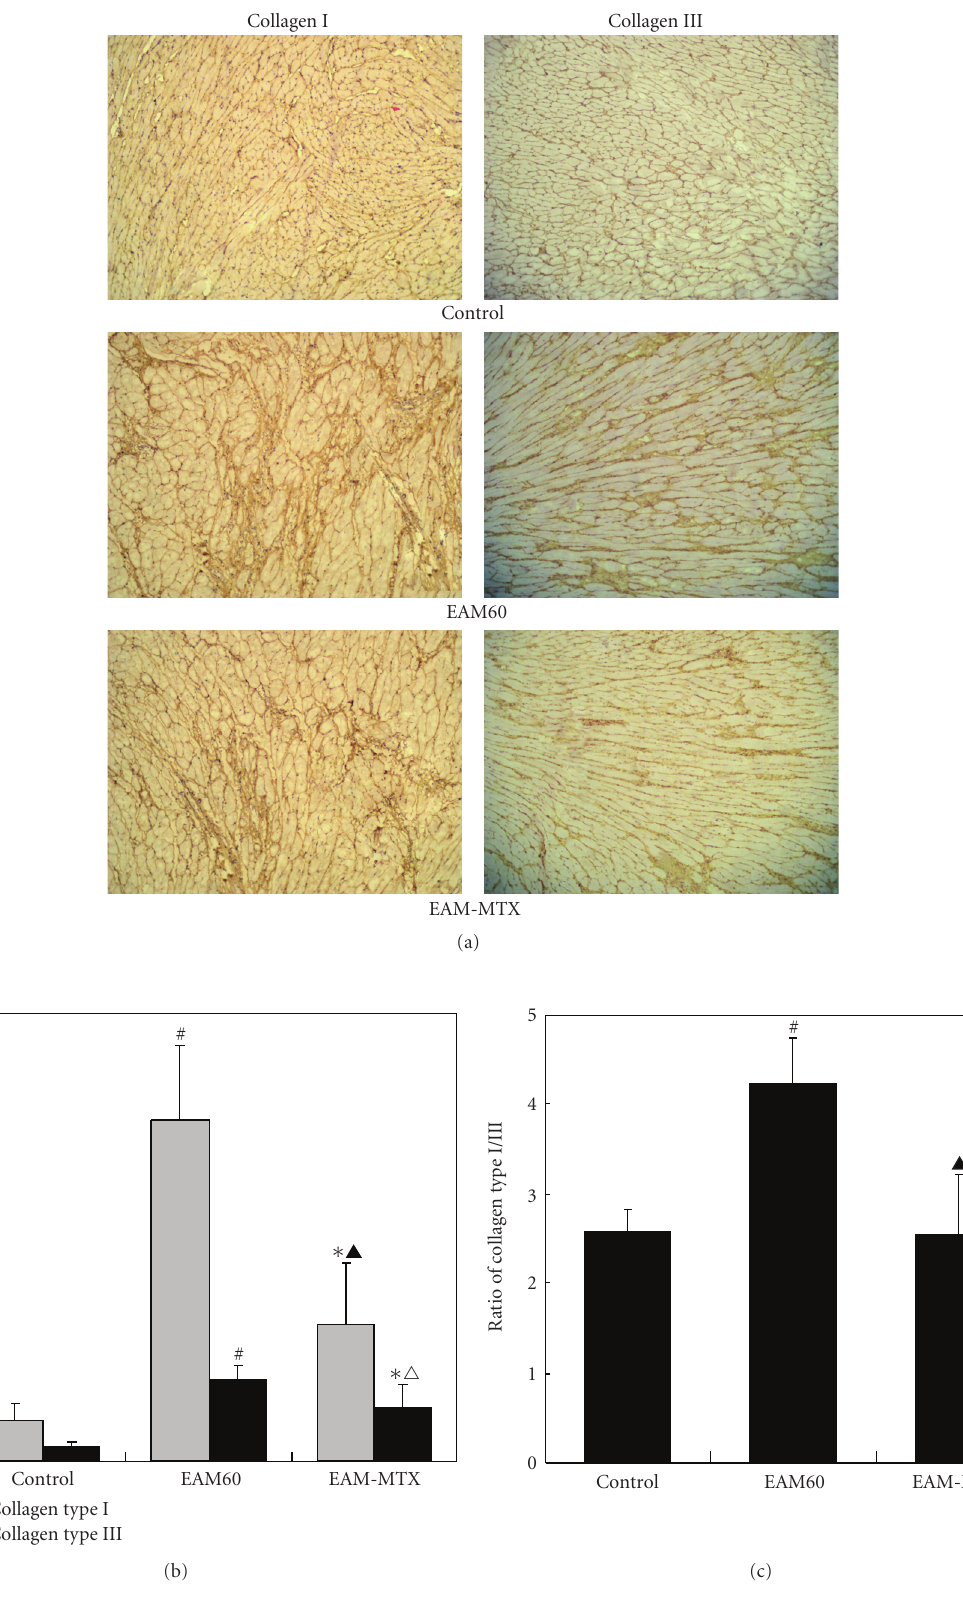
Figure 4: Collagen types I and III staining. Representative photomicrographs of ventricular sections from the three groups of rats are shown ((a); × 200). The areas of collagen types I and III were, measured (b) and the ratios of collagen type I/III were calculated (c). All results are (cid:2) P < .05, (cid:2) P < .01 versus EAM60 represented as mean ± SD ( n = 10). ∗ P < .05, # P < .01 versus control group;